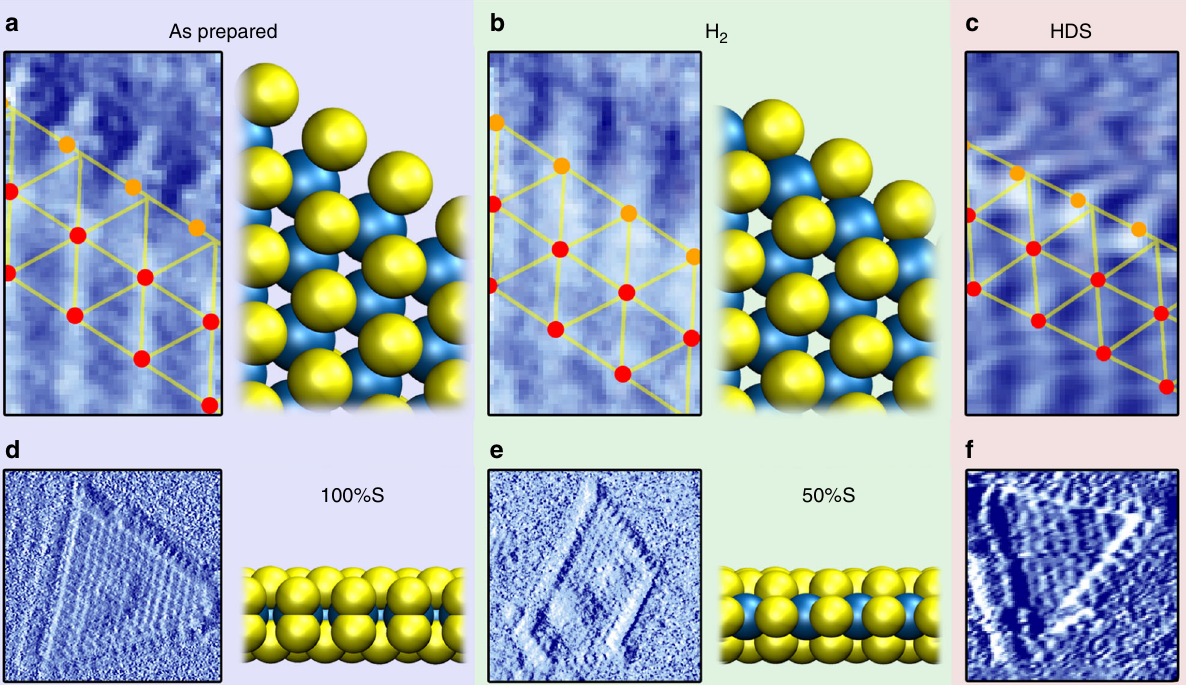
Fig. 2 MoS 2 edge structure in various gas environments. The bottom panels ( d , e , f ) show the original images, which were differentiated (in the fast scanning direction) to highlight the atomic contrast. The top panels ( a , b , c ) depict the averaged edge unit cell obtained from the bottom panels ( d , e , f ). The ball models represent the 100%S and 50%S structures that could directly be identi fi ed for ( a ) and ( b ), respectively, from comparison to simulated STM images (see Supplementary Figs. 1 and 2). Blue: Mo, yellow: S. a , d Catalyst after preparation in 2 × 10 − 6 mbar H 2 S at 450 °C, imaged in UHV at room temperature. 6.6 × 6.6 nm 2 , U bias = − 0.3 V, I t = 560 pA. b , e Catalyst imaged in 1 bar H 2 at 50 °C. 6.6 × 6.6 nm 2 , U bias = − 0.3 V, I t = 630 pA. c , f